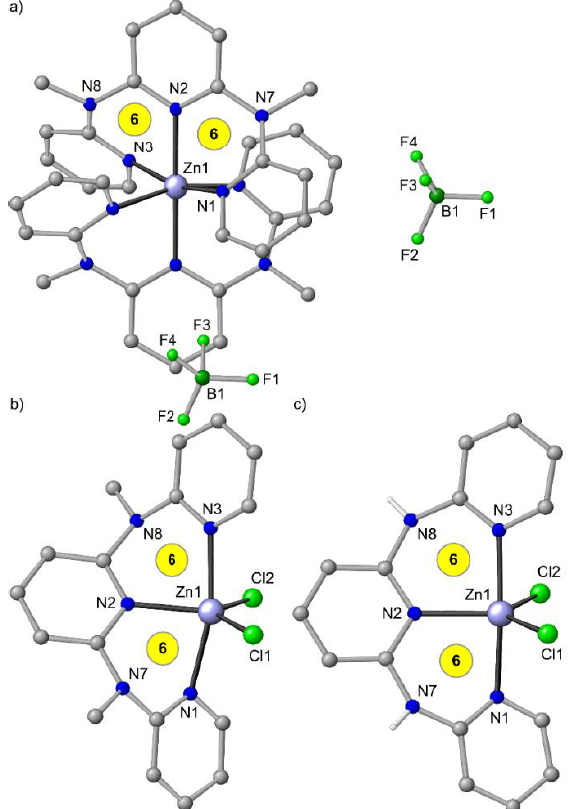
Figure 3. ( a ) Molecular structures of mer -[Zn(ddpd) 2 ][BF 4 ] 2 [49], ( b ) ZnCl 2 (ddpd) from the mer -[Zn(ddpd) 2 ][ZnCl 4 ]/Zn(ddpd)Cl 2 co-crystal [49] and ( c ) ZnCl 2 (H 2 tpda) [41] in the solid state. Carbon-bound hydrogen atoms and solvent molecules omitted. Atom numbering unified for clarity. Chelate ring sizes highlighted in yellow.